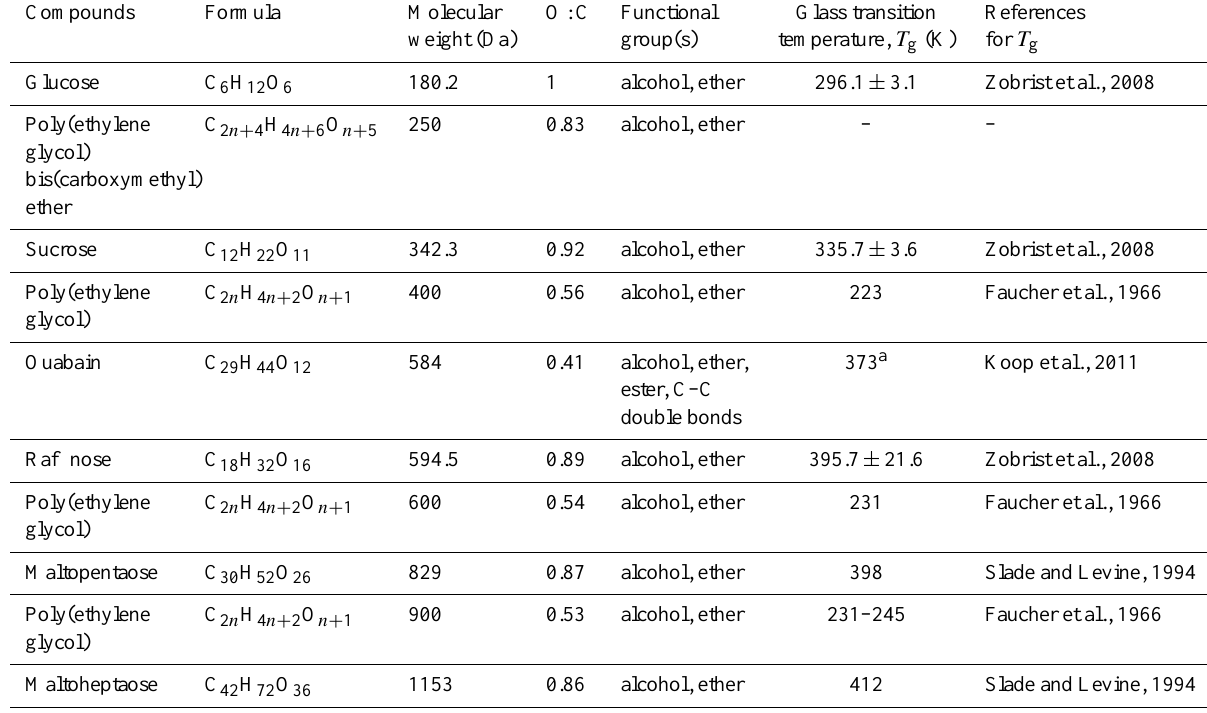
Table 1. List of the 10 organic species used in molecular-weight-dependent measurements. Each organic species was separately mixed with ammonium sulfate to make particles, and liquid–liquid phase separation was studied in these particles at 290 ± 1K.